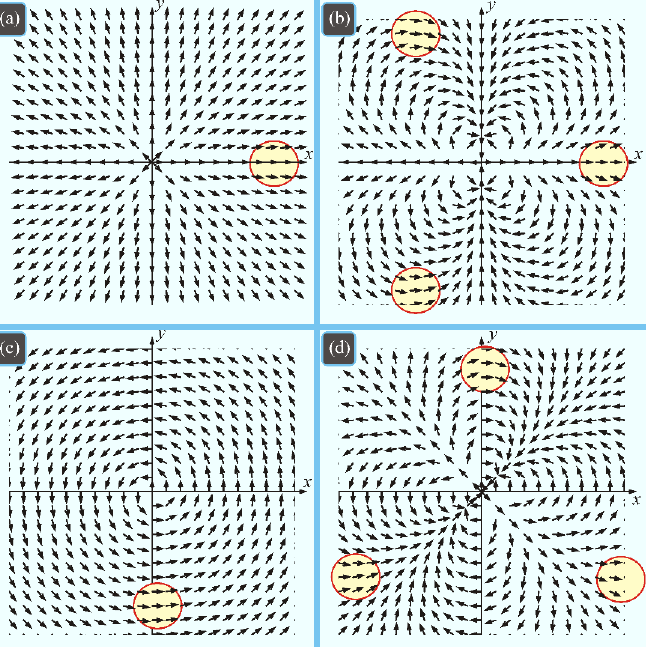
Figure 1. Jones vectors for fields with ( a ) first- and ( b ) third-order radial polarization ( n = 1, 3), and ( c ) first- and ( d ) third-order azimuthal polarization ( n = 1, 3). Encircled regions highlight the polarization vectors directed to the right.